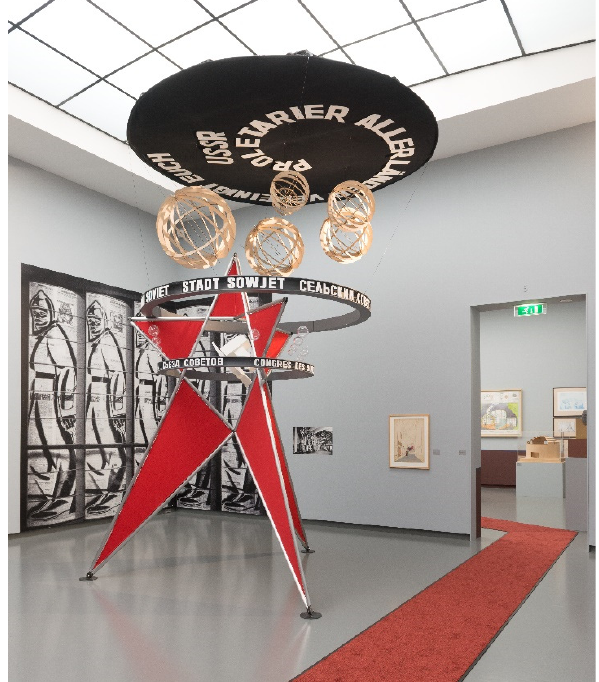
Figure 31. View of one of the rooms in the exhibition ‘Lissitzky–Kabakov: Utopia and Reality’, Van Abbemuseum, 2012. Front: model after El Lissitzky, ‘Pressa Star’, 1927, reconstruction by Henry Milner, 2012. Van Abbemuseum. Photo: Peter Cox.